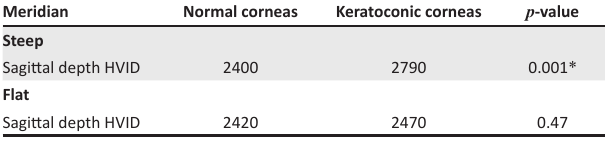
TABLE 2: Sagittal depth measurements of 14 normal versus 14 keratoconic corneas (from Sorbara et al. 8 ). Meridian